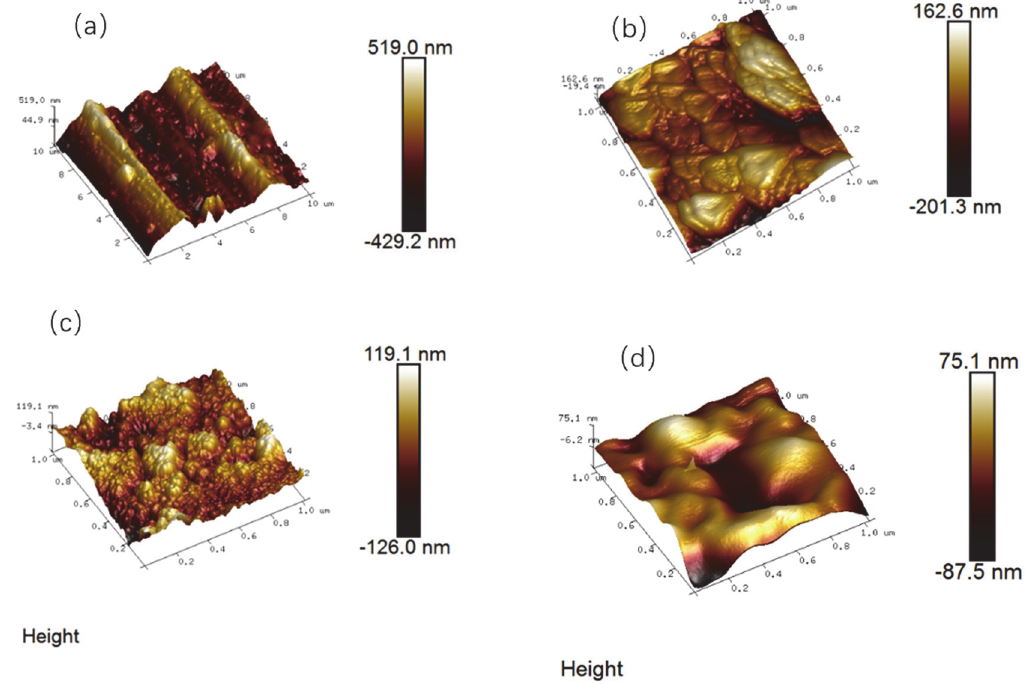
Figure 5. Atomic force microscope (AFM) tapping mode 3D images of ( a ) the Al alloy, ( b ) anodic oxide film, ( c ) sol–gel film, and ( d ) LBL film.